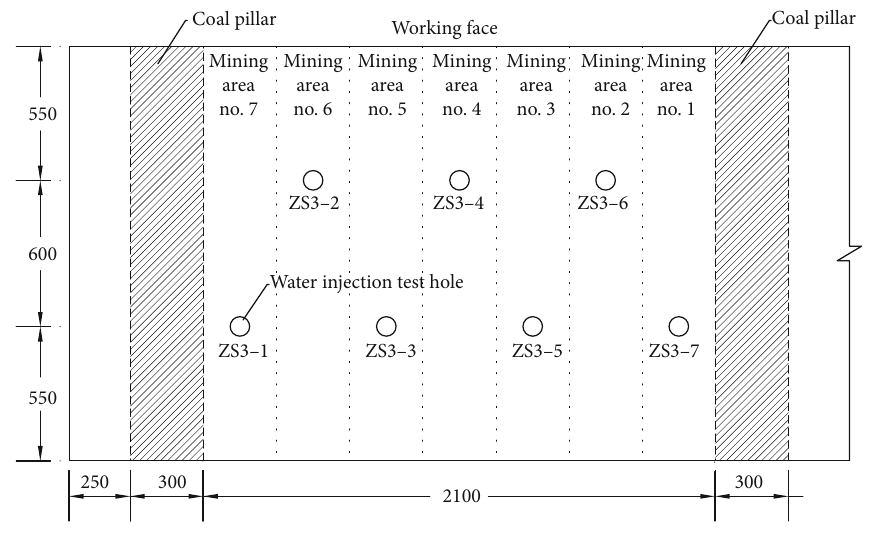
Figure 16: Plane layout of water injection test points (units: mm).